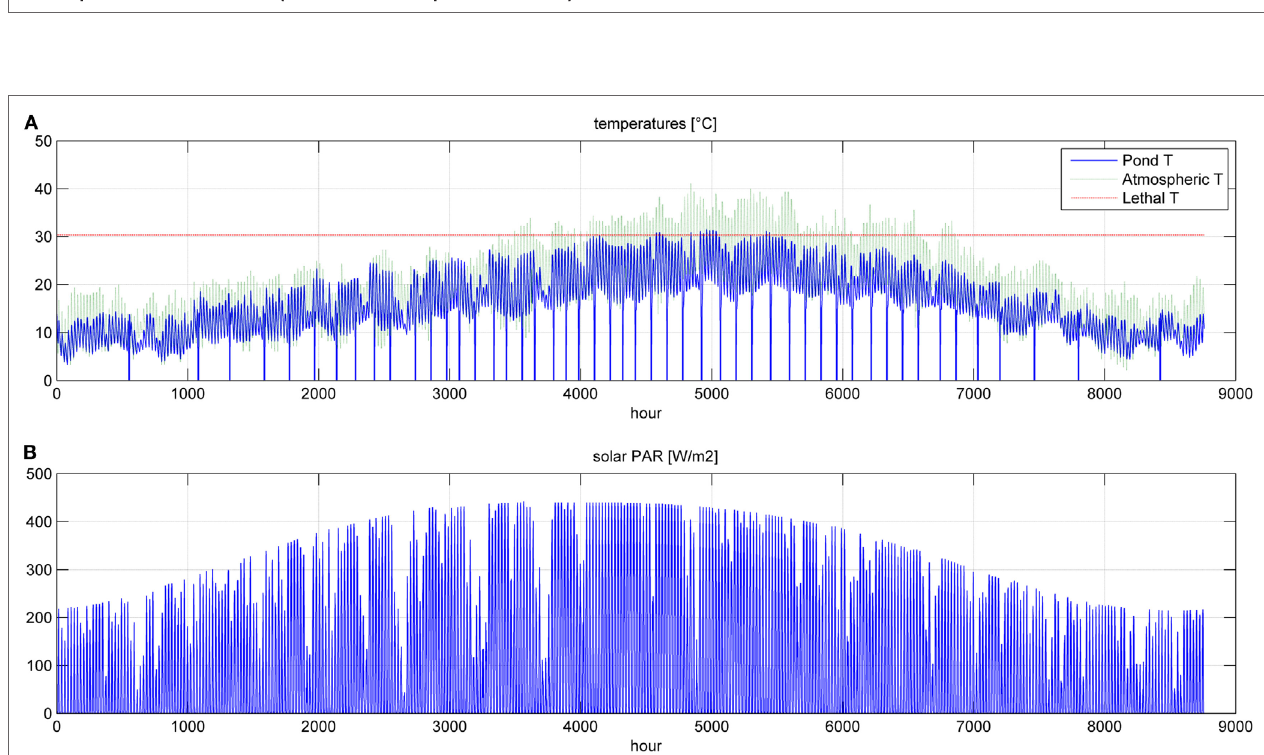
FigUre 8 | Temperatures (a) and photosynthetic active radiation (B) for a simulation time equal to 1 year .